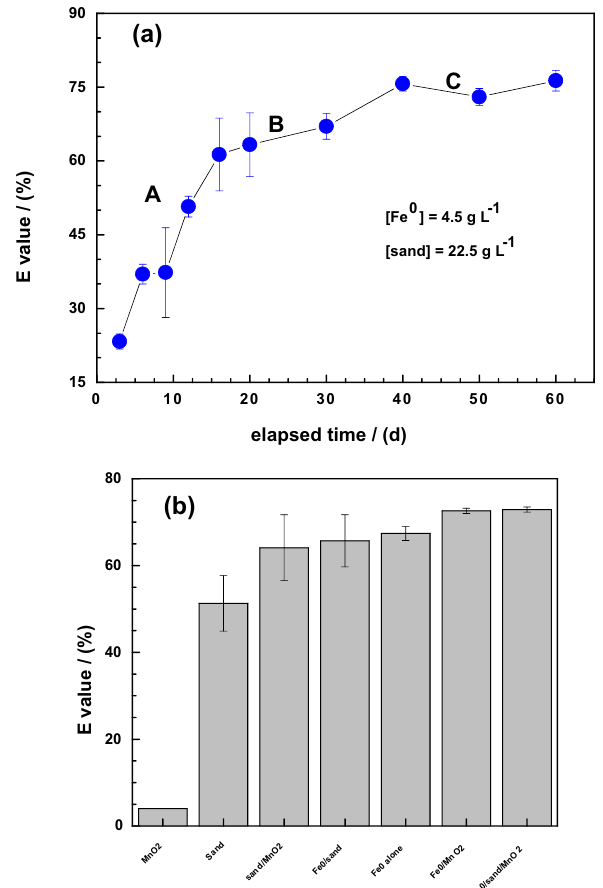
Figure 1. Comparison of the efficiency of tested materials for methylene blue (MB) discoloration: ( a ) for 0 to 60 days in Fe0/sand system, and ( b ) by the tested systems for 47 days. Experimental conditions: [Fe 0 ] = 2.3 to 45 g L −1 in ( a ), 4.5 g L −1 in ( b ); [sand] = 45 g L −1 ; and [MnO 2 ] = 2.3 g L −1 in ( a ) and 4.5 g L −1 in ( b ). The lines are not fitting functions, they simply connect points to facilitate visualization.